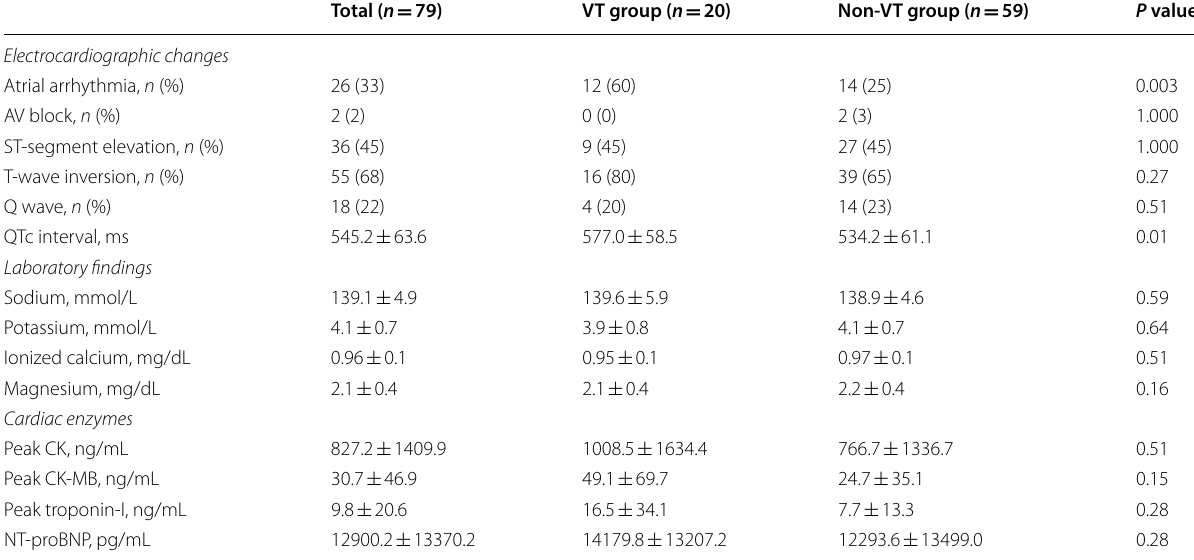
Values are mean SD or number (%); VT ventricular tachycardia; Atrial arrhythmia: PSVT, atrial tachycardia, atrial fibrillation; CK creatine kinase; CK-MB creatine kinase- ± myocardial band; NT-proBNP N-terminal pro-brain natriuretic peptide